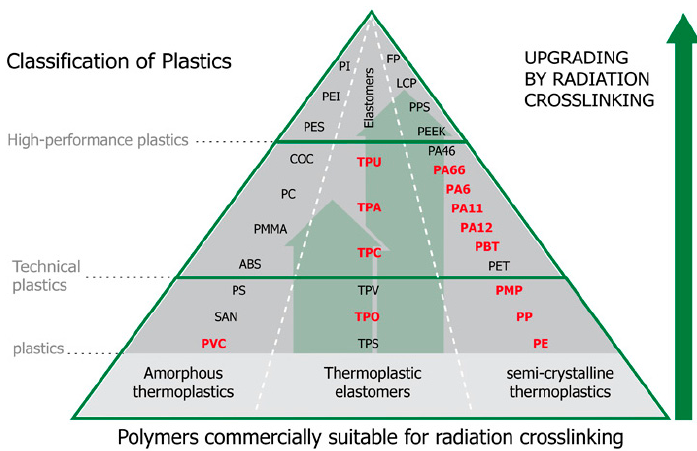
Figure 1. Upgrading properties by radiation crosslinking [25].